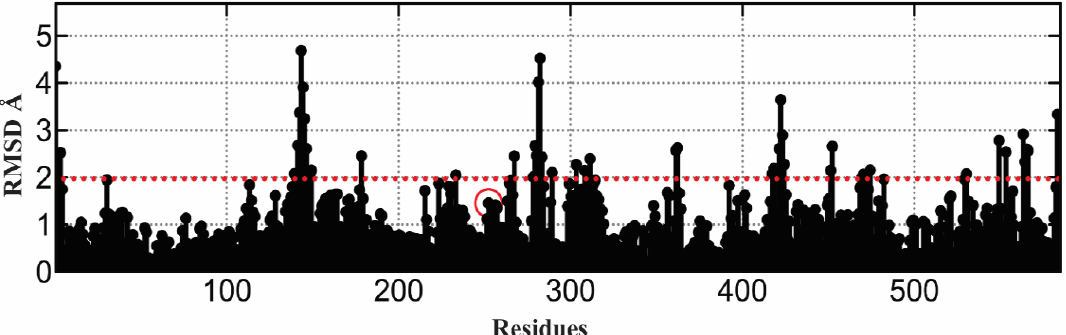
Figure 7. Homology model of α -glucosidase aligned and superimposed with template RMSD in angstroms. The red line shows the template RMSD values while the red circles identified the cata- lytic residues.